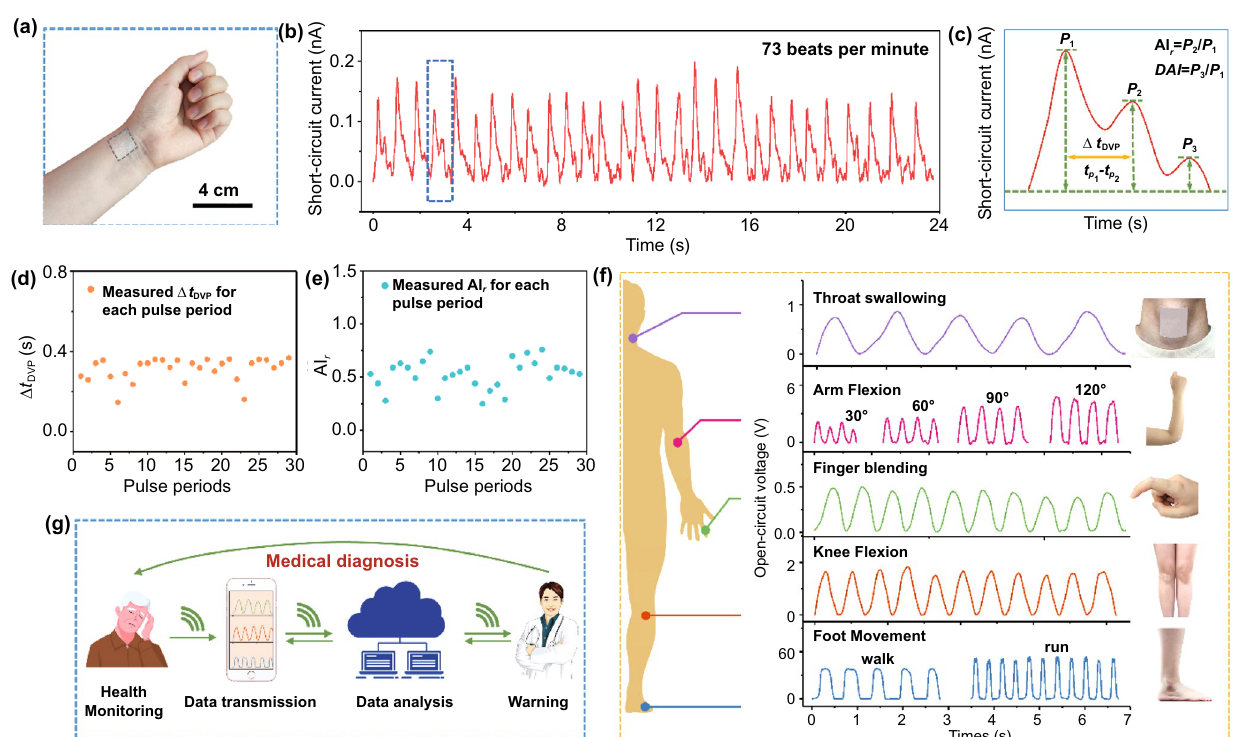
Fig. 4 Health status signal monitoring by the ITM. a The ITM was attached onto the wrist for pulse detection; b the 25-s real-time and con- tinuous monitoring of the pulse signals from the ITM; c one enlarged pulse signal from the pulse periods. d , e ∆ t DVP and AI r derived from 29 measured complete pulse periods; f the ITM for whole-body activities monitoring; g illustration of next-generation intelligent mobile diagnosis